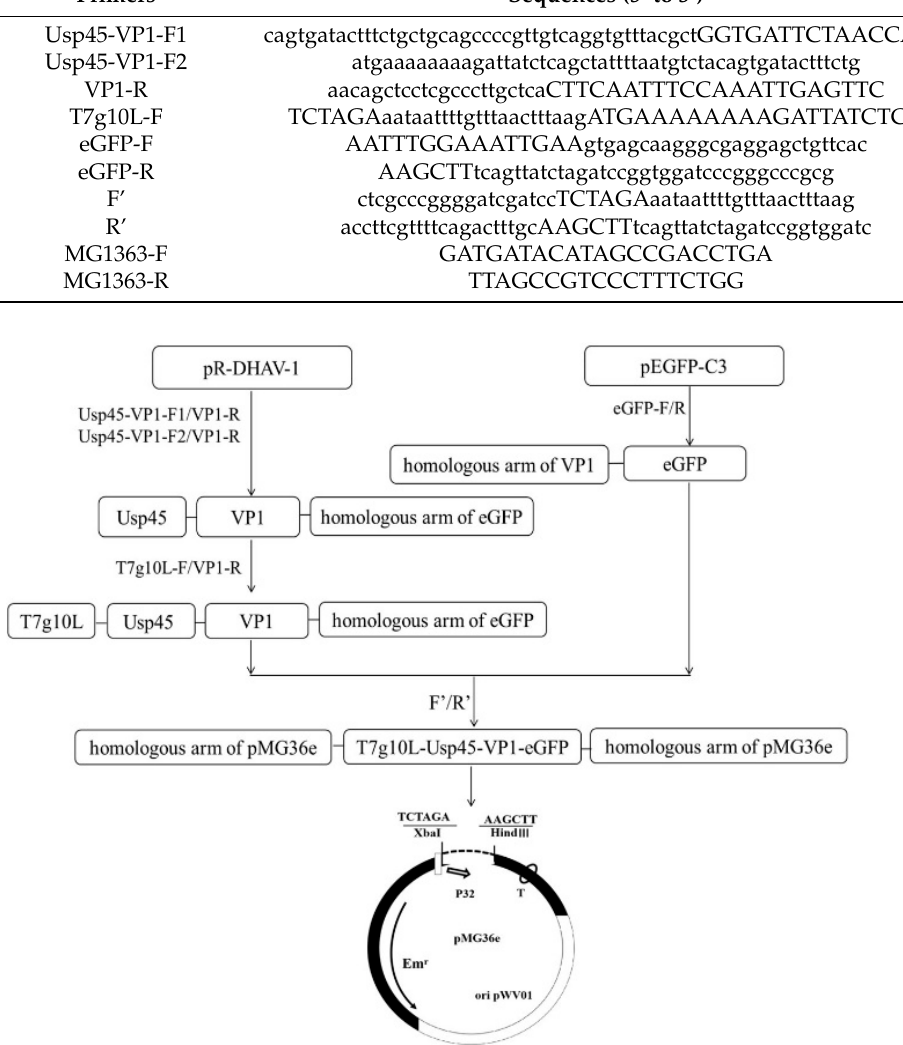
Figure 1. Construction diagram of the recombinant plasmid. The fused